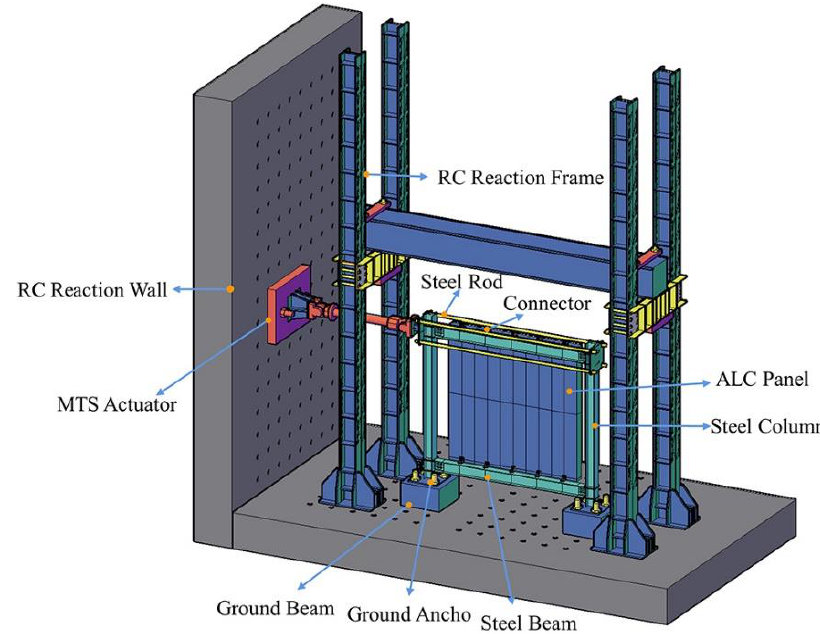
Figure 4. Loading device diagram.